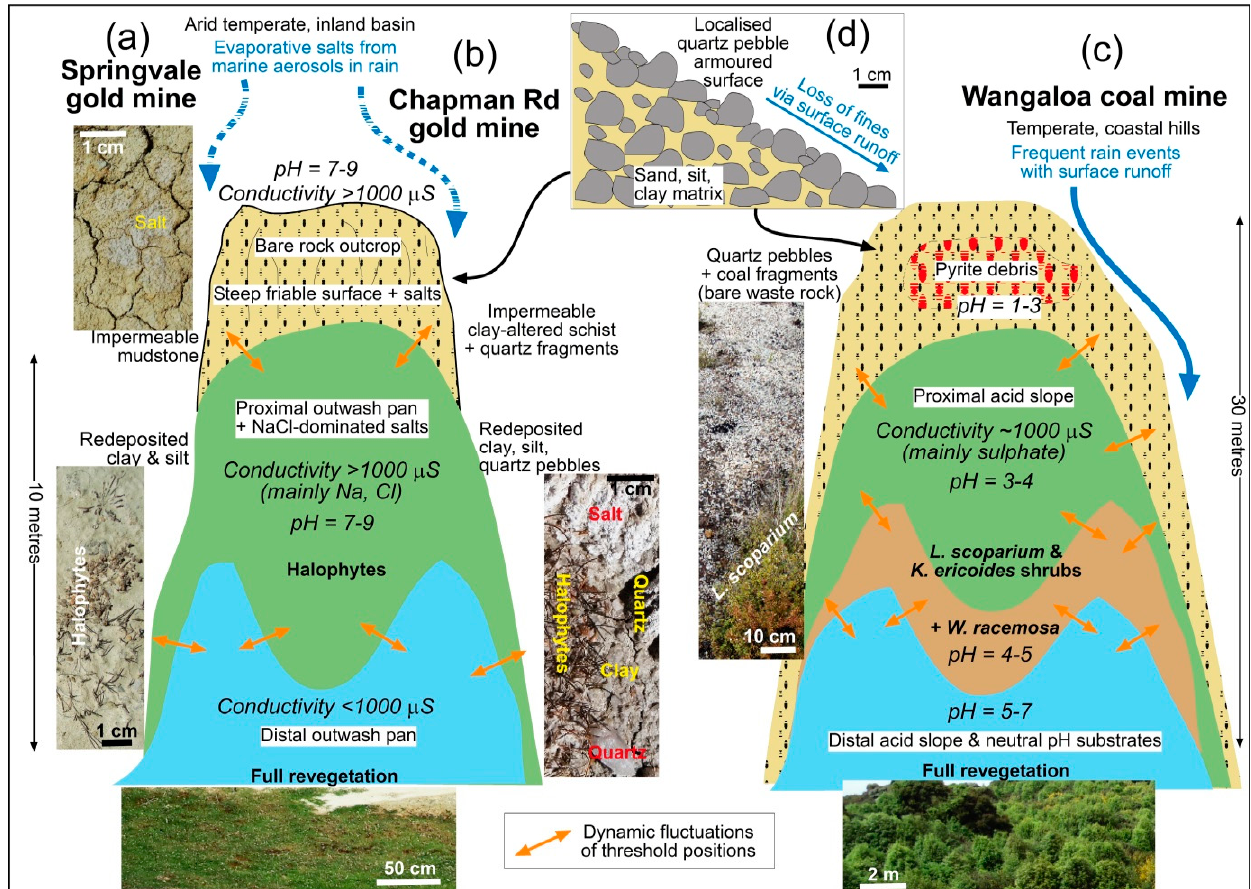
Figure 8. Cartoon summary of the principal features of geoecological zonation at the three historic mine sites in this study [35]. Threshold boundaries between the geoecological zones are dynamic on time scales of years to decades. ( a ) Springvale placer gold mine. ( b ) Chapman Road placer gold mine. ( c ) Wangaloa coal mine. ( d ) Sketch cross section through a waste rock slope rich in quartz pebbles, where pebble armouring of the slope forms a physical barrier to plant colonisation at both Chapman Road and Wangaloa mine sites.